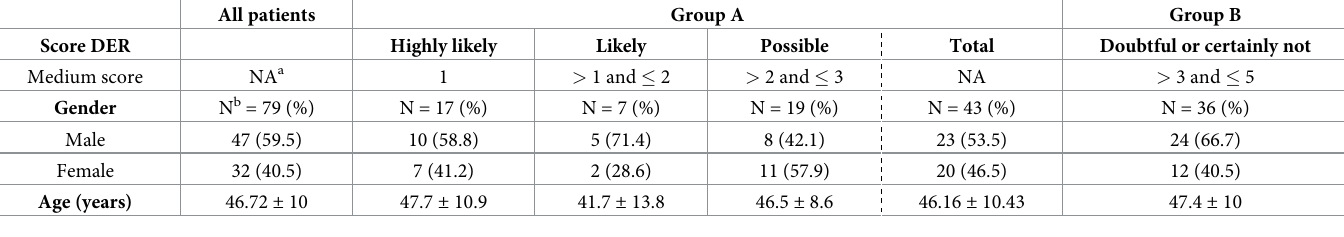
Table 1. Demographics and DER scores of patients with a history of DIS treatment and ethanol use admitted to the ED of the University Hospital of Ghent between October 1, 2010 and September 30, 2014. Scores are given as the medium value and the range of the individual scores by the 6 panel members. Patients are grouped (A and B) according to the likelihood of a